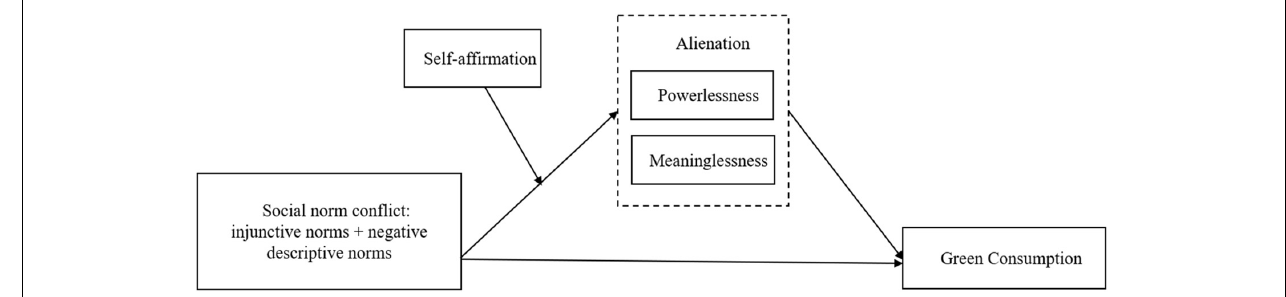
FIGURE 1 | The conceptual model of this